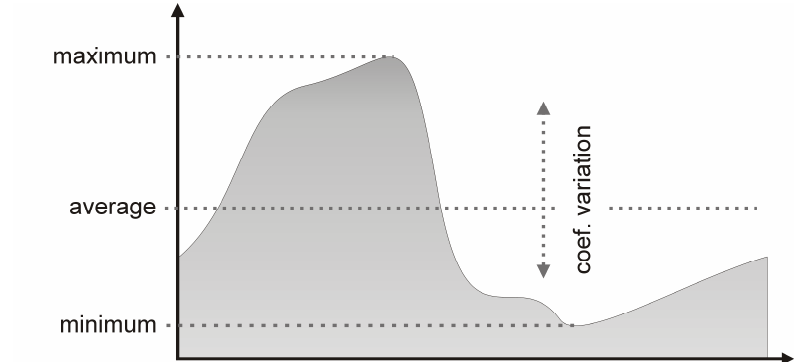
Figure 1. Scheme of the behaviour of the NDVI for a typical year of a deciduous forest, showing the variables selected to describe functional